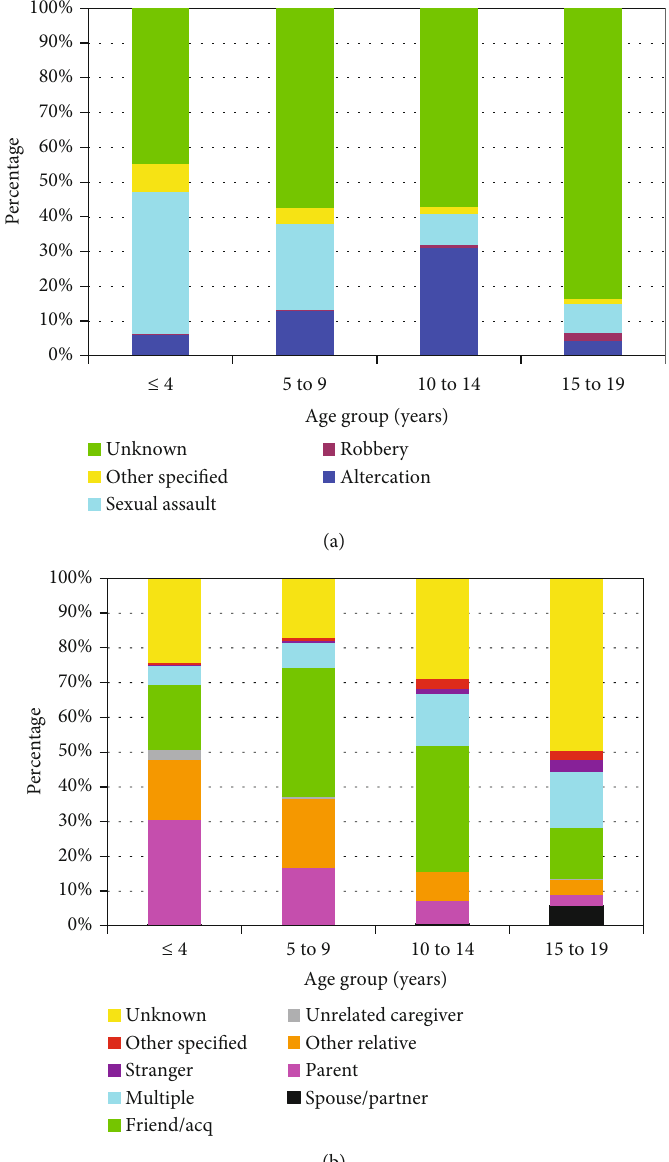
Figure 2: Di ff erences by gender in child and adolescent assault victims. (a) By reason for assault ( p < 10 − 4 ). (b) By perpetrator of assault ( p < 10 − 4